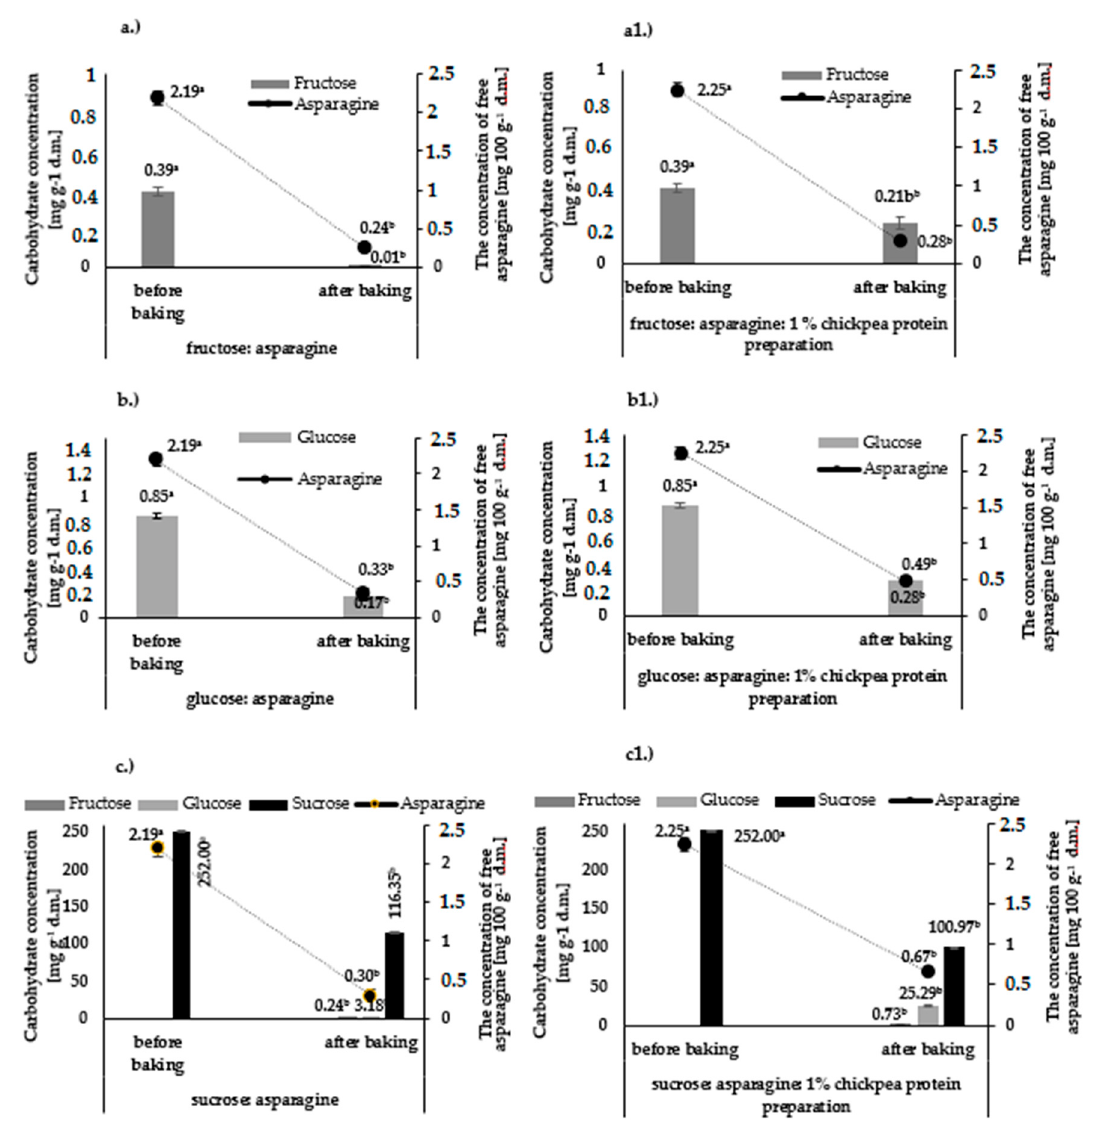
Figure 1. Concentration of carbohydrates and free asparagine in model systems with and without 1% chickpea protein preparation: fructose: asparagine ( a ), fructose–asparagine–1% chickpea protein preparation ( a1 ), glucose–asparagine ( b ), glucose–asparagine–1% chickpea protein preparation ( b1 ), sucrose–asparagine ( c ), sucrose–asparagine–1% chickpea protein preparation ( c1 ) , before and after baking; lowercase letters—different letters in the same figure indicate significant differences in the content of individual carbohydrates and asparagine within the same model system before and after baking ( n = 3; p ≤ 0.05); data are presented as means ± SD.